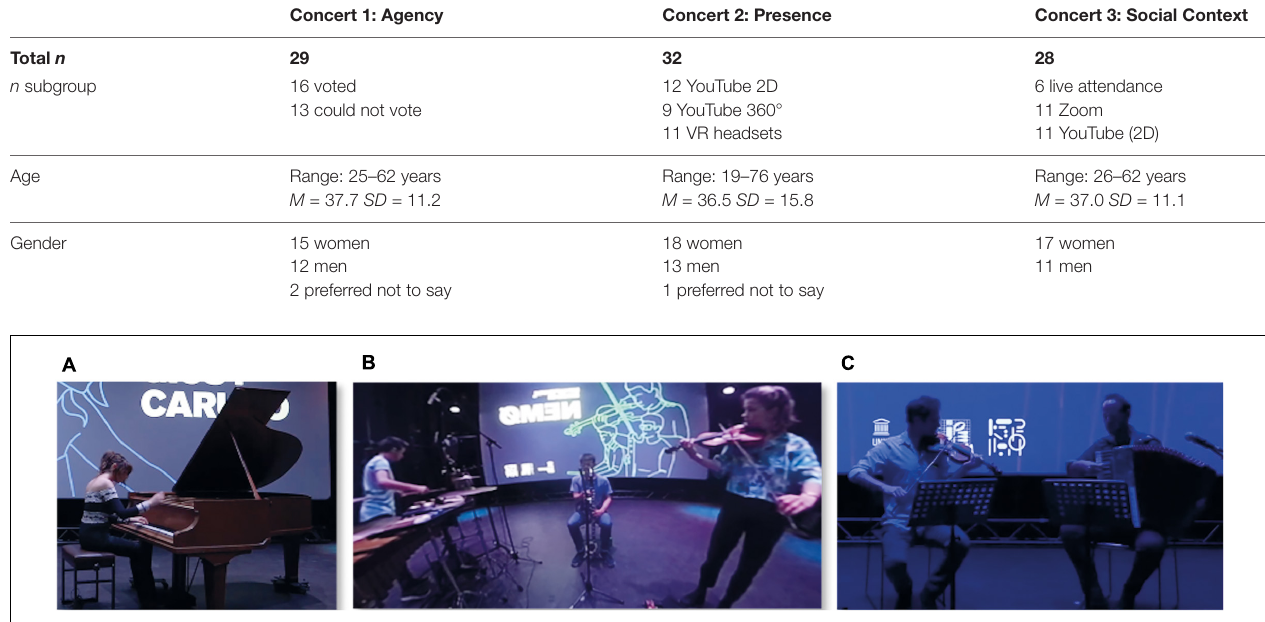
TABLE 1 | Amount of people who completed the post-concert questionnaire, number of participants per subgroup, and general demographics. Concert 1: Agency Concert 2: Presence